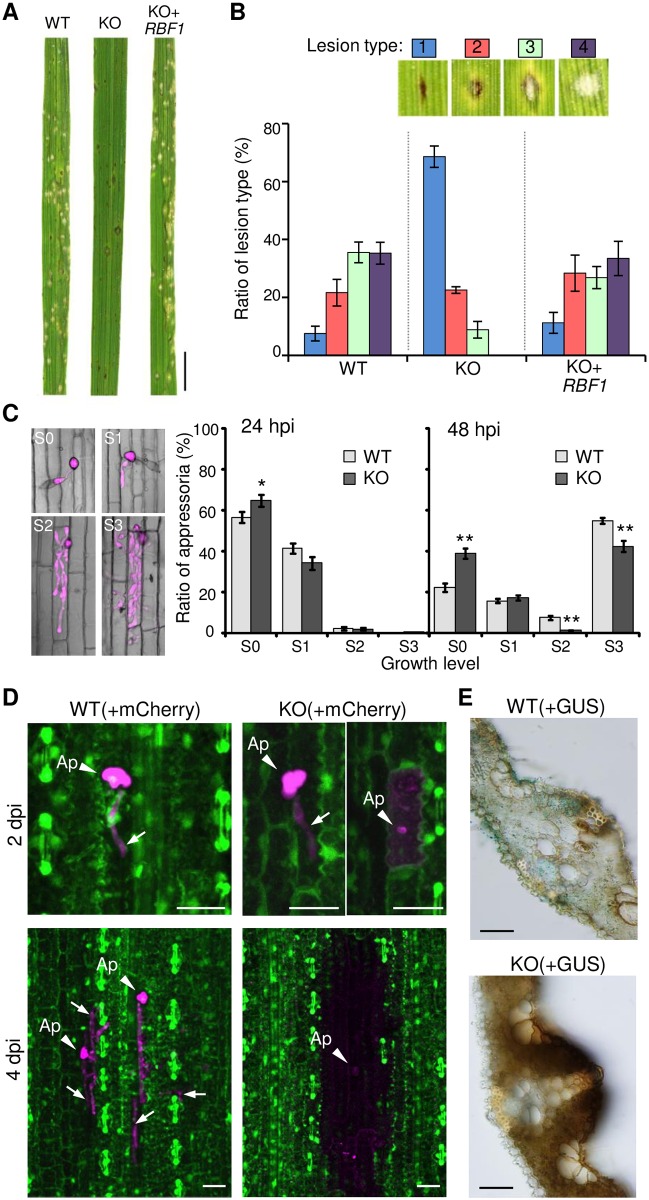

RBF1 is a virulence determinant in Magnaporthe oryzae.
(A) Representative symptoms on the 6th leaf blades at 5 days after inoculation. Rice plants were sprayed with a conidial suspension of the wild-type strain (WT), an RBF1-knockout line (Δrbf1-1; KO), and a gene complementation line (KO+RBF1). Bar = 5 mm. (B) Evaluation of lesion types in leaf blades. Lesions formed at 5 days after spray-inoculation were counted according to the classifications displayed. Data are represented as the mean percentages ± SE (n = 5 plants). (C) Comparison of the development of invasive hyphae in rice leaf sheaths between WT and Δrbf1-1 (KO). Infection levels in leaf sheaths were assessed for each appressorium under a microscope and categorized as no invasion (S0), short invasive hyphae in one cell (S1), highly-branched invasive hyphae in one cell (S2), and multiple cell invasion (S3). To illustrate each category, typical images using a WT line transformed with TEFp::mCherry are displayed. Data are represented as the mean percentages ± SE [n = 14 plants (24 h post inoculation; hpi) and 23 plants (42 hpi)]. Student’s t-test was performed on arcsine-transformed data between WT and KO (*, P < 0.05; **, P < 0.005). The total numbers of appressoria observed per line were ~ 1,500 (24 hpi) and 3,000 (48 hpi). (D) Confocal images of rice epidermal cells in inoculated leaf blades. Transgenic rice plants constitutively expressing GFP under the CaMV 35S promoter were inoculated with the WT (left) or Δrbf1-2 line (KO; right) transformed with TEFp::mCherry. GFP and mCherry signals were merged. Note that the disappearance of the GFP signal (green) indicates host cell death. Arrows indicate invasive hyphae. Ap, appressorium. Bar = 20 μm. (E) Transverse sections of inoculated rice leaf blades at 6 dpi. To visualize invasive hyphae, the WT (upper) and Δrbf1-1 (KO; lower) were transformed with TEFp::GUS. Spot-inoculated rice leaf blades were stained for β-glucuronidase activity, hand-sectioned, and observed by light microscopy. Bar = 0.1 mm.